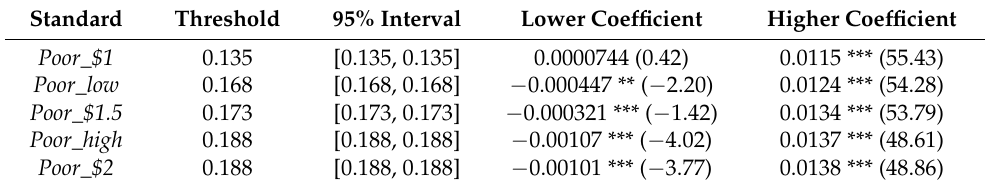
Table 20. Threshold estimates, confidence intervals, and coefficient changes.